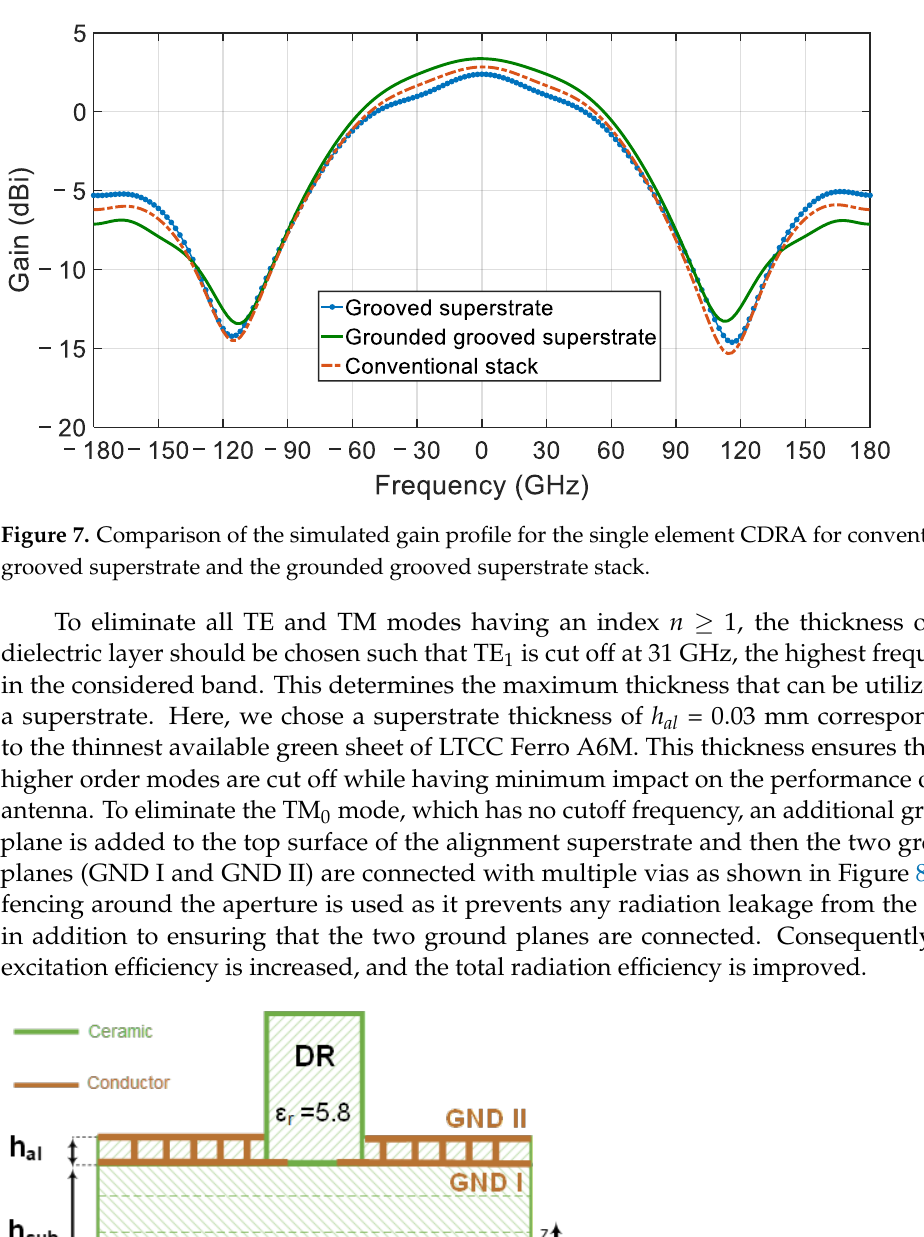
Figure 8. Schematic of the proposed stack with grounded and grooved superstrate for the